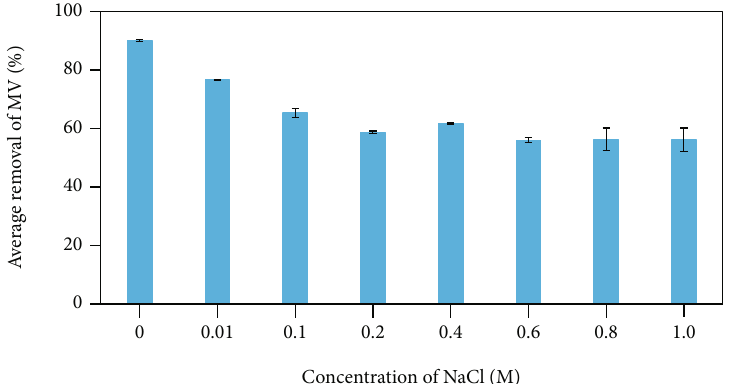
Figure 6: The e ff ect of ionic strength of NaOH-KR for the removal of MV dye (mass of adsorbent = 0 : 020 g; volume of MV solution = 10 : 0 mL; concentration of MV = 100 mgL -1